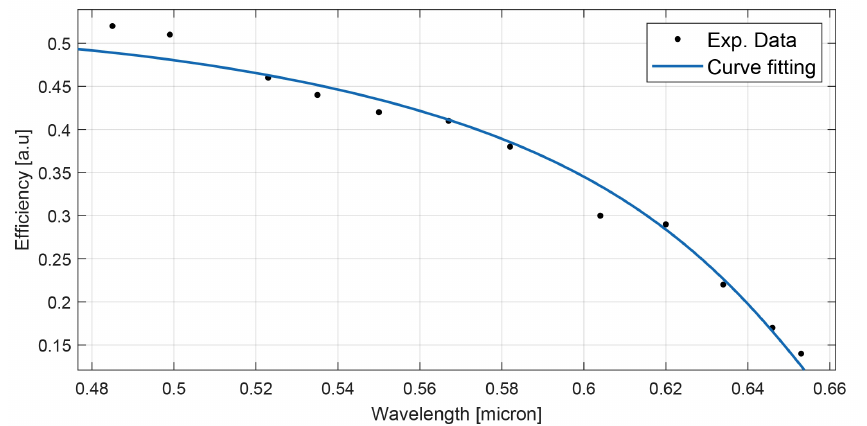
Figure 5. Diffraction efficiency values reported as a function of the wavelength. Each wavelength corresponds to a different Bragg angle for the diffracted signal. The continuous line represents the experimental data